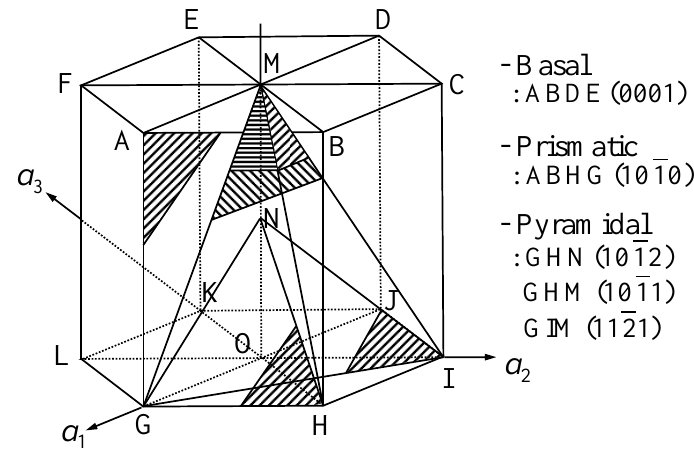
Figure 2. Important planes in a hexagonal close-packed (HCP) structure.